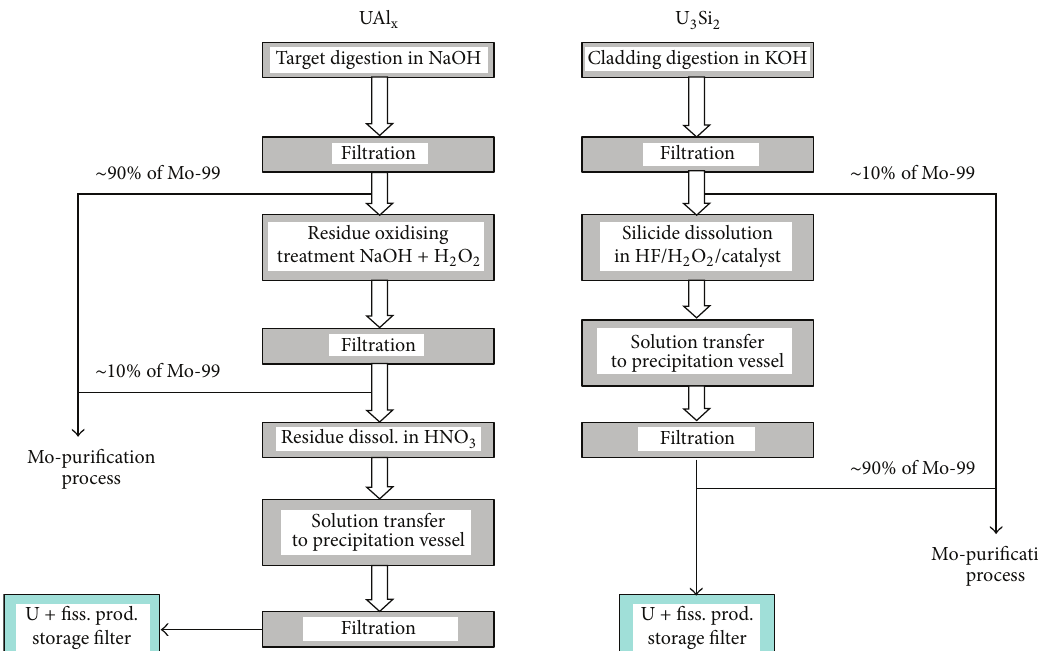
Figure 17: Fission Mo-99 production flow sheets for irradiated UAl 𝑥 and U 3 Si 2 fueled